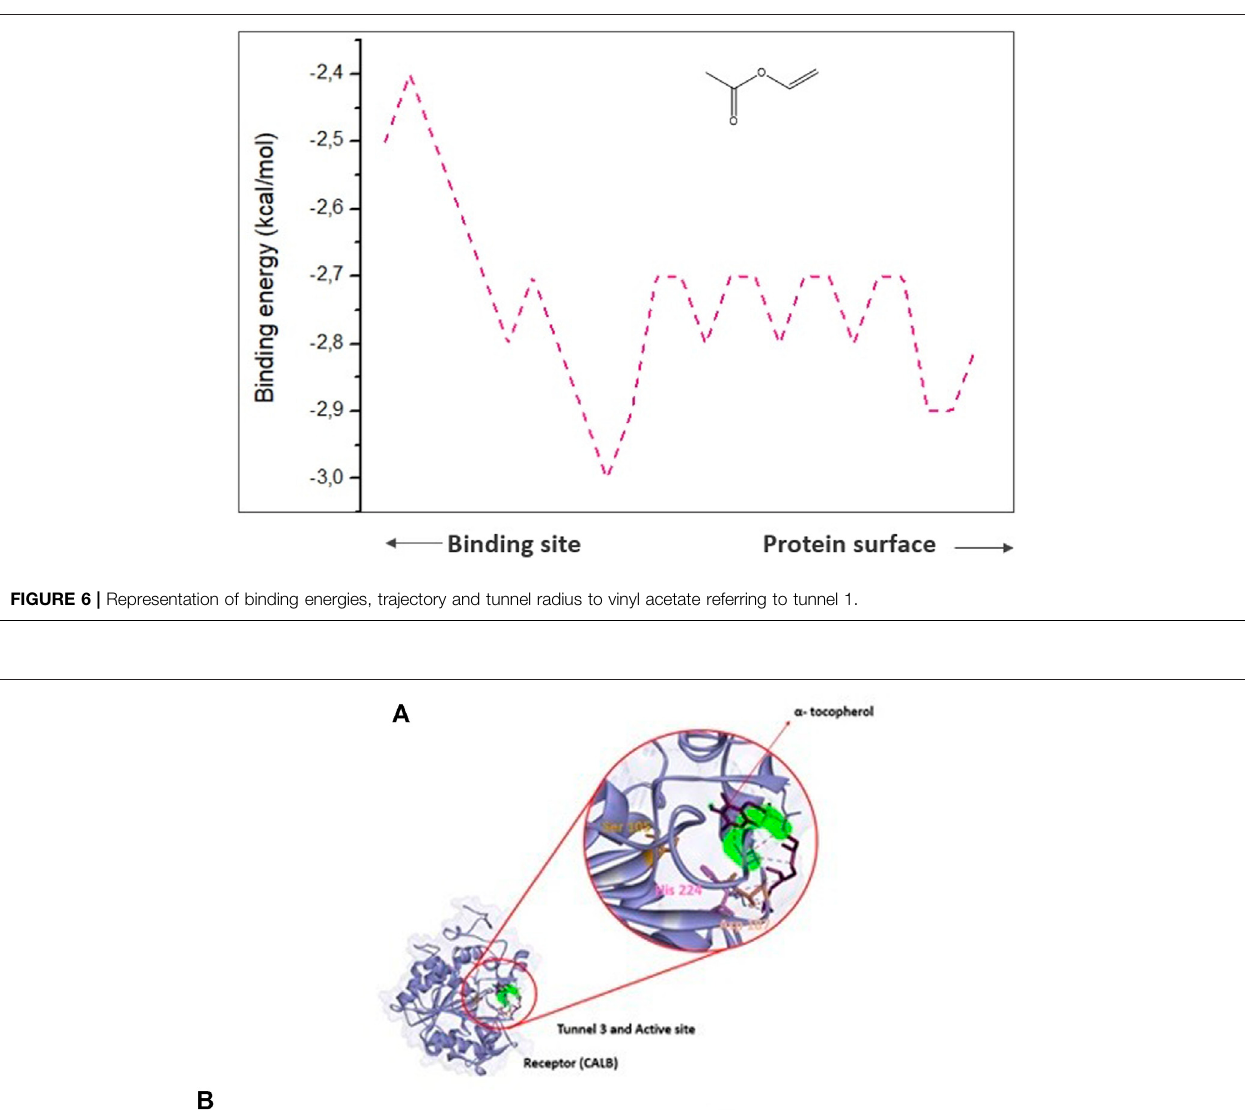
Frontiers in Bioengineering and Biotechnology |